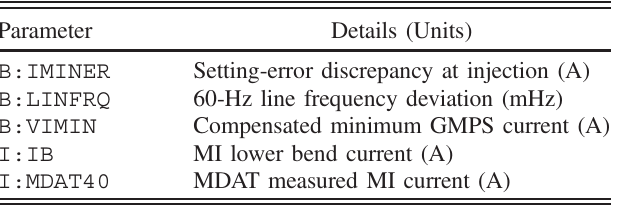
TABLE I. Description of dataset parameters chosen by experts and later validated with a causality study. Here, “ MI ” means main injector, “ MDAT ” means accelerator (machine) data communi- cation, and device parameters that begin with B are related to the booster, whereas device parameters that begin with I are related to the main injector (reused with permission from the authors of